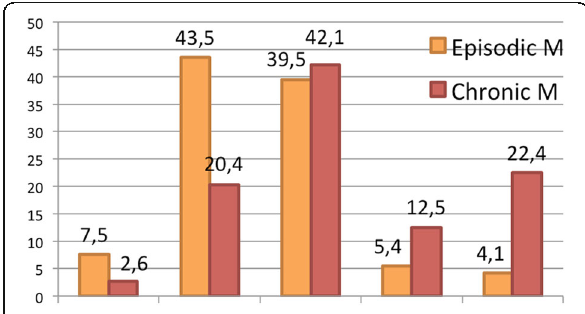
Fig. 5 Number of oral preventative failures prior to the OnabotA therapy. Numbers represent the percentage of responders that affirmed to start OnabotA after the failure of each number of therapeutic failures. In orange, answers from Headache Specialists; Green, answers from general